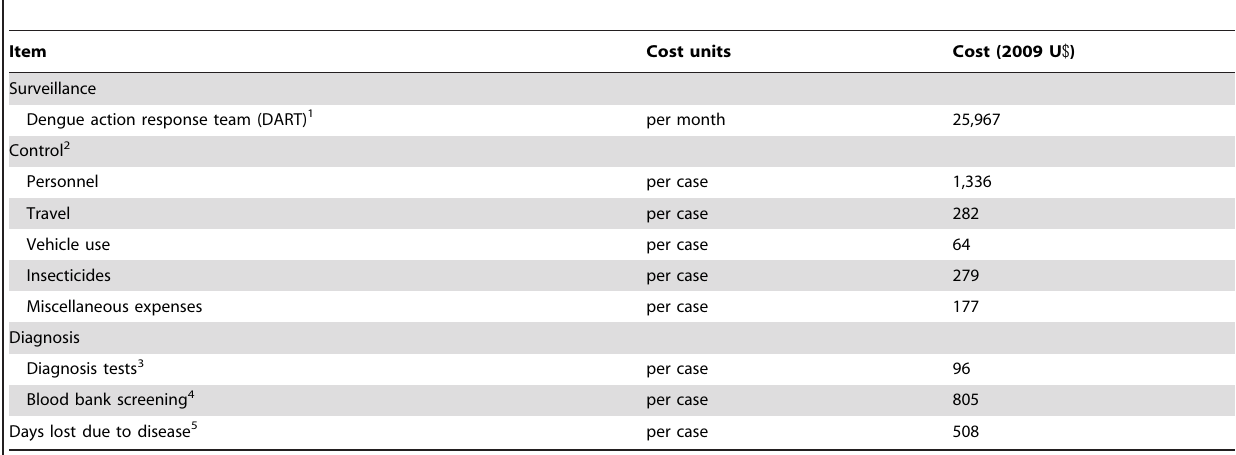
Table 1. Cost estimates per month (during surveillance) and per case (during an outbreak) to prevent and control dengue fever introductions in Cairns,